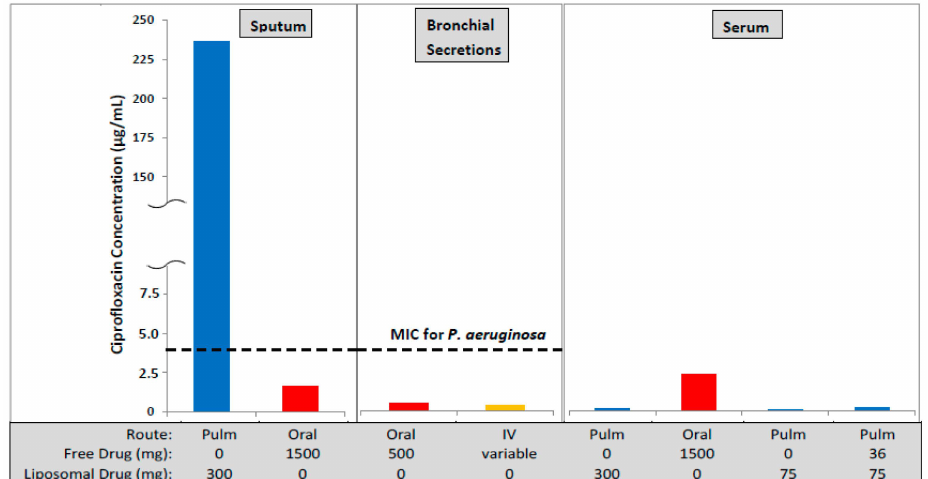
Figure 1. The concentration of ciprofloxacin in lung sputum ( C max ), bronchial secretions